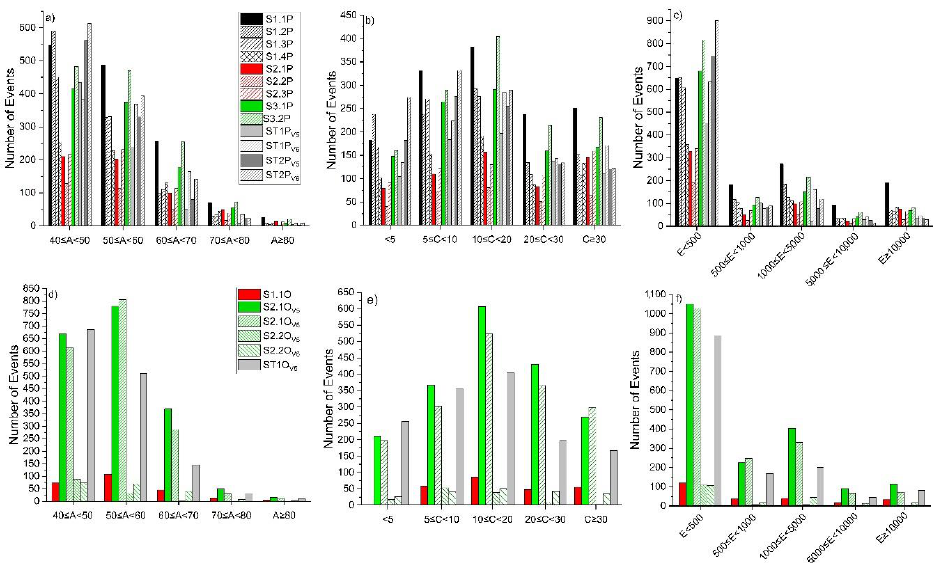
Figure 4. Distribution of AE parameters in ductile-like (DL) state. ( a ) Amplitude, pine; ( b ) Counts, pine; ( c ) Energy, pine; ( d ) Amplitude, oak; ( e ) Counts, oak; ( f ) Energy, oak.